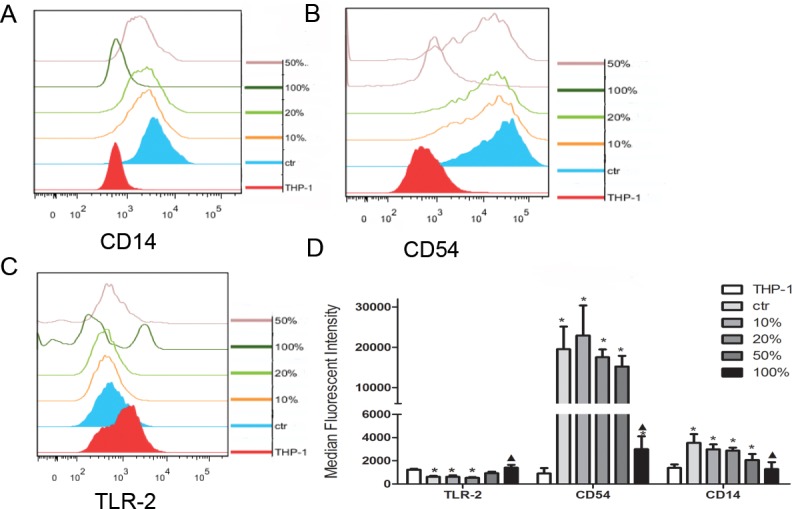
The impact of PMA and JDBM extracts on cell differentiation of THP-1 cells into macrophage.PMA treatment alone was pos-ctr, PRMI 1640 treatment alone was neg-ctr. (A-C) representative results of FACS test on CD14, CD54 and TLR-2, respectively, after induced by JDBM extract cell differentiation performance in various extract assayed. THP-1 cell without PMA was THP-1 and with PMA was ctr. (D) Statistical results of the expression change on CD14, CD54 and TLR-2 of cell under various extracts. *P < 0.05 vs ctr, ▲P < 0.05 vs THP-1.